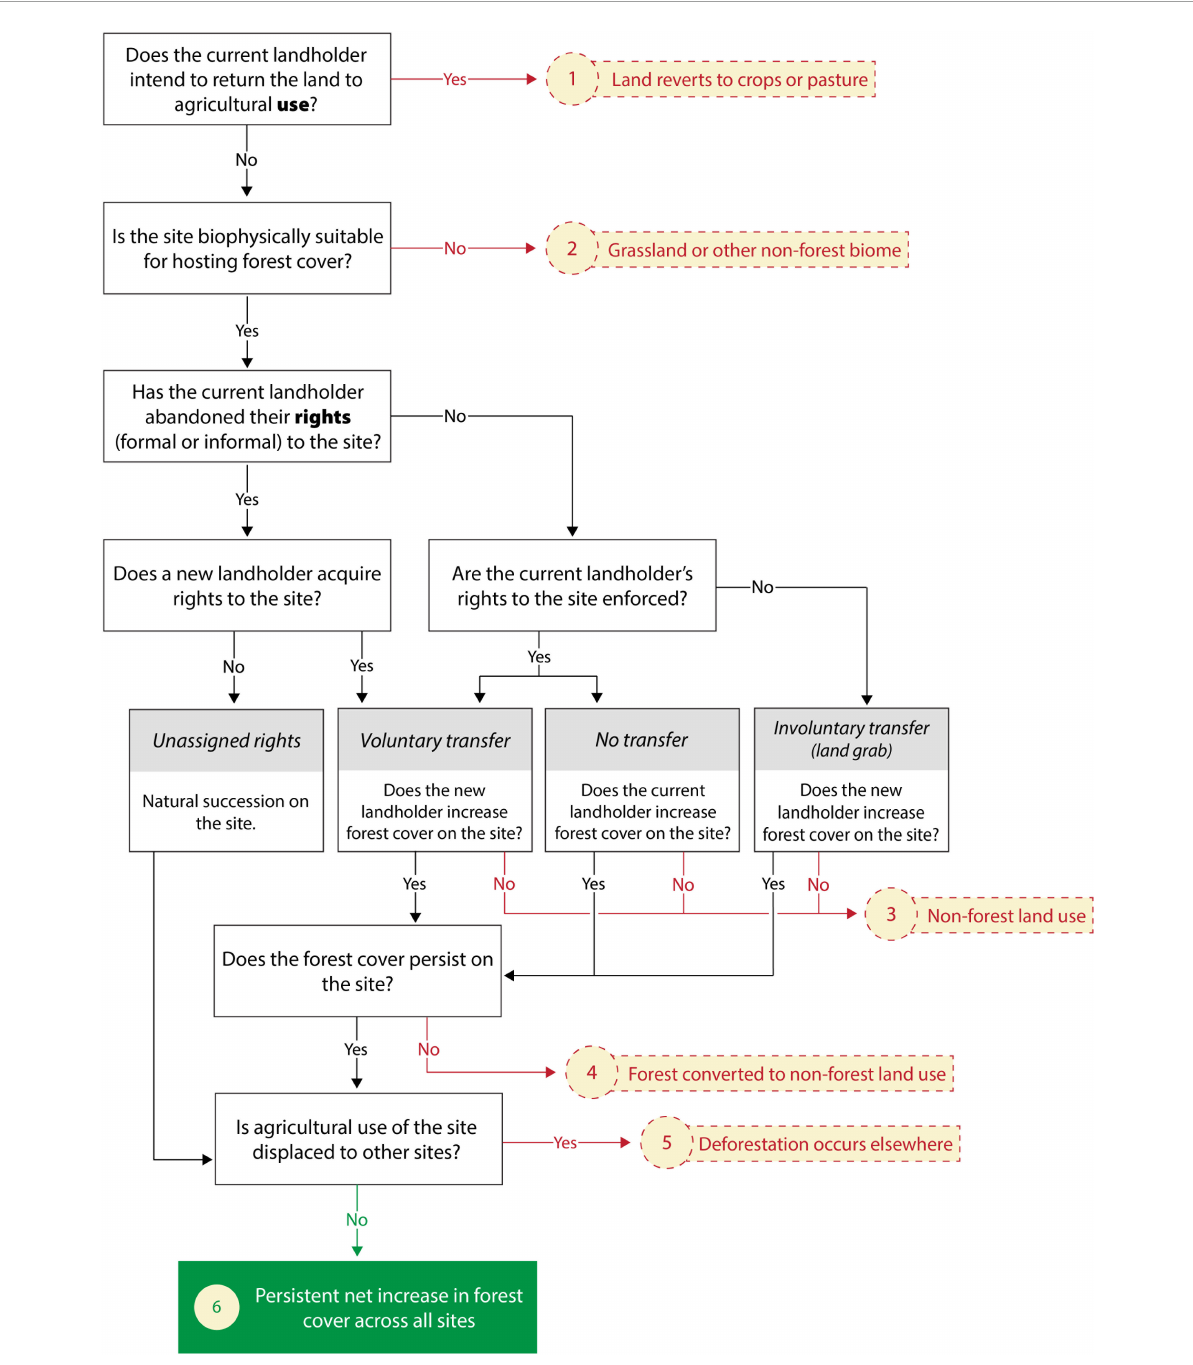
FIGURE1 Flowchart of factors affecting whether temporary cessation of agriculture use of land results in a persistent net increase in forest cover. Red arrows indicate an exit from the possibility of a net increase in forest cover; green arrow indicates an arrival at a net increase in forest cover; black arrows indicate intermediate paths that do not lead directly to a change in forest cover. Numbered outcomes are referenced and explained in the text. Landholder includes both landowners and other people who use the land but lack clear title to the